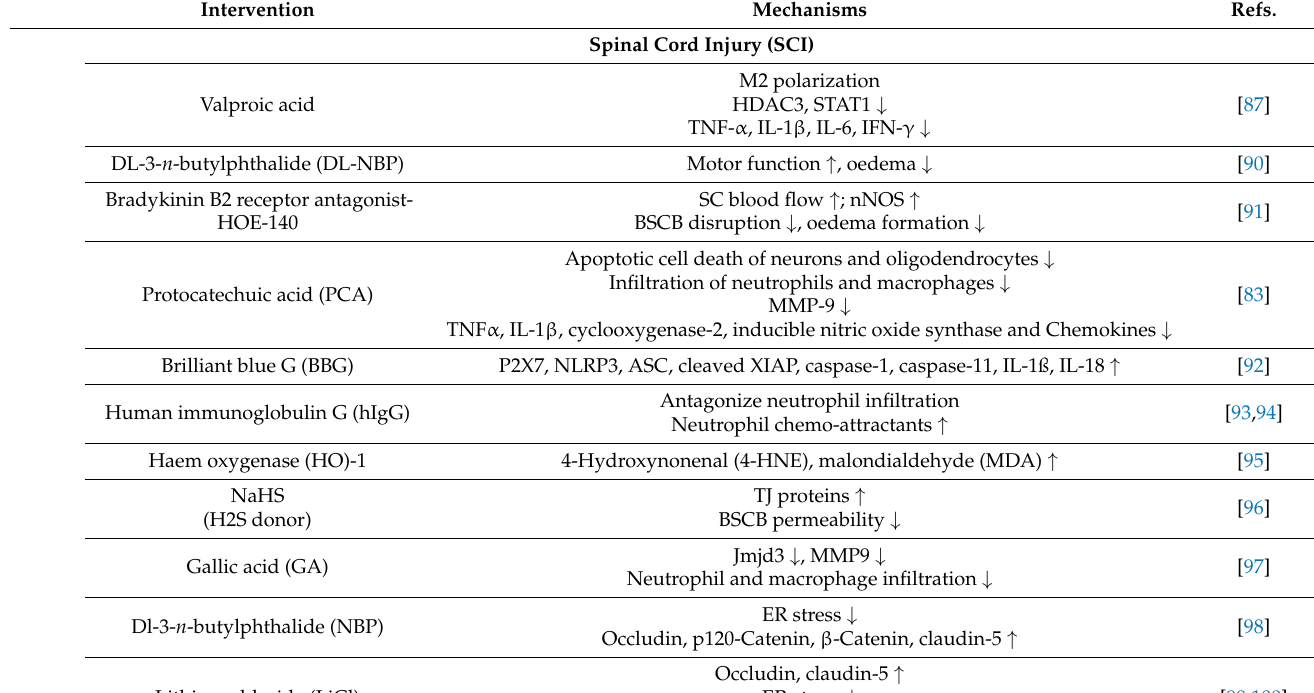
Table 3. Therapeutic options for blood-spinal cord barrier in different spinal cord